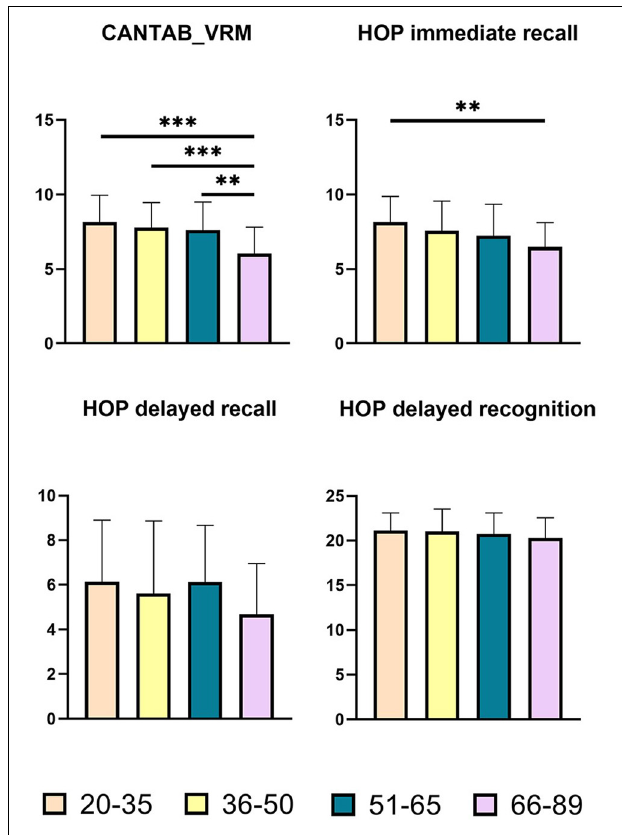
FIGURE 2 | Pairwise comparisons of memory scores between age groups. X -axis, age groups; Y -axis, memory scores. ∗∗ P < 0.01, ∗∗∗ P < 0.001. CANTAB_VRM, Cambridge Neuropsychological Test Automated Battery verbal recognition memory; HOP immediate recall, Hopkins immediate recall;